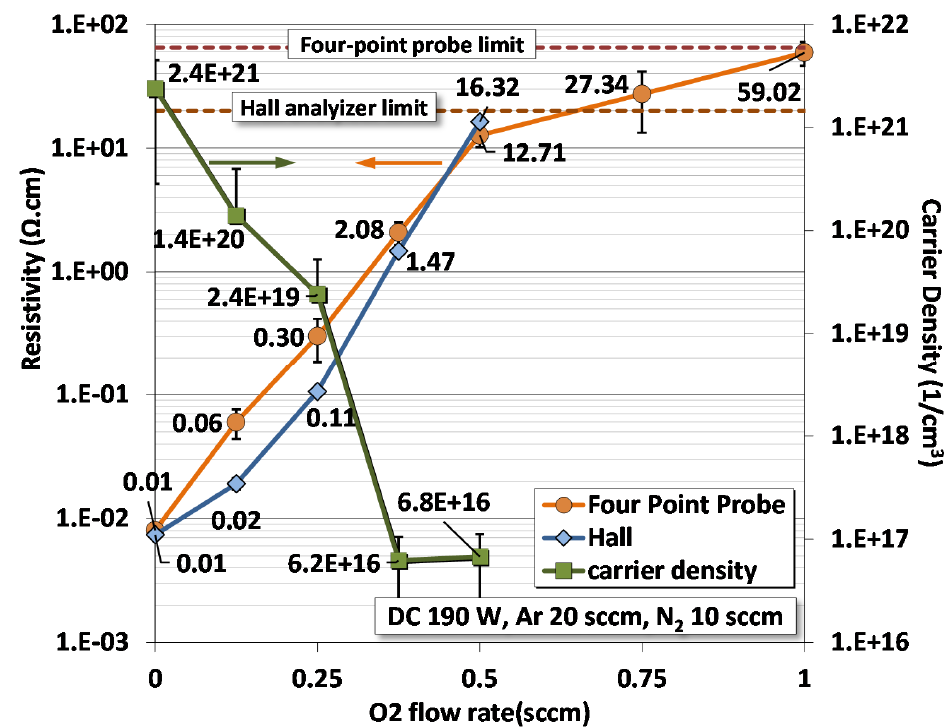
Figure 6. Electrical resistivity and carrier density of annealed films under different oxygen flow rates.